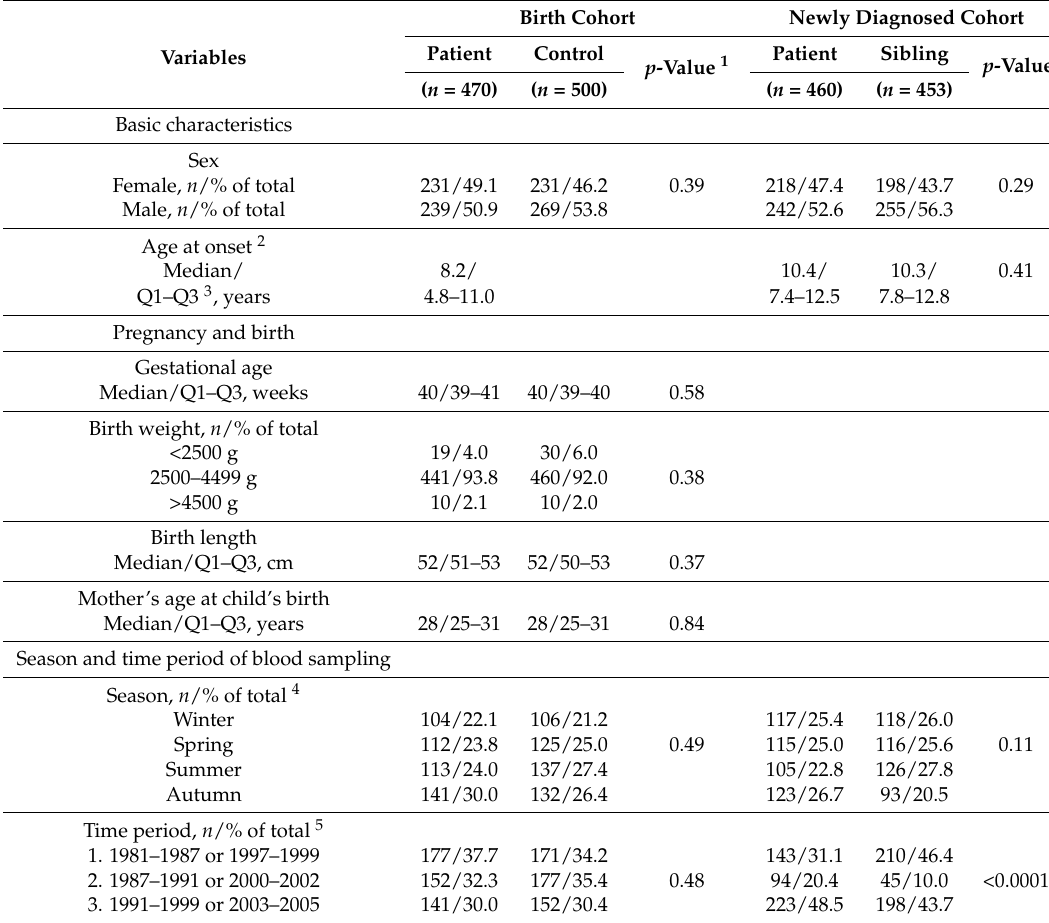
Table 1. Descriptive characteristics of the two pediatric